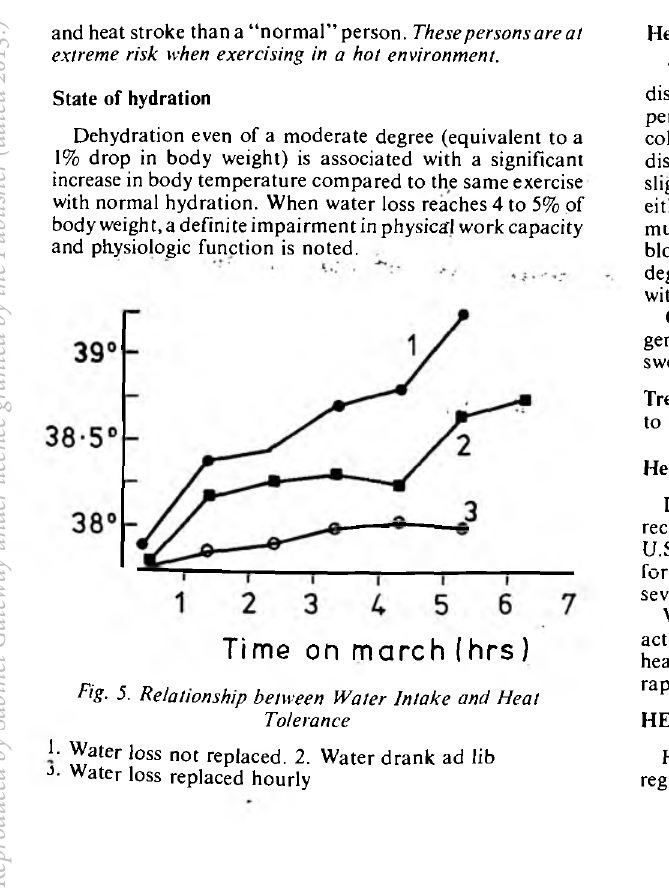
• Untrained subjects □ Trained subjects Fig. 4. Relationship between